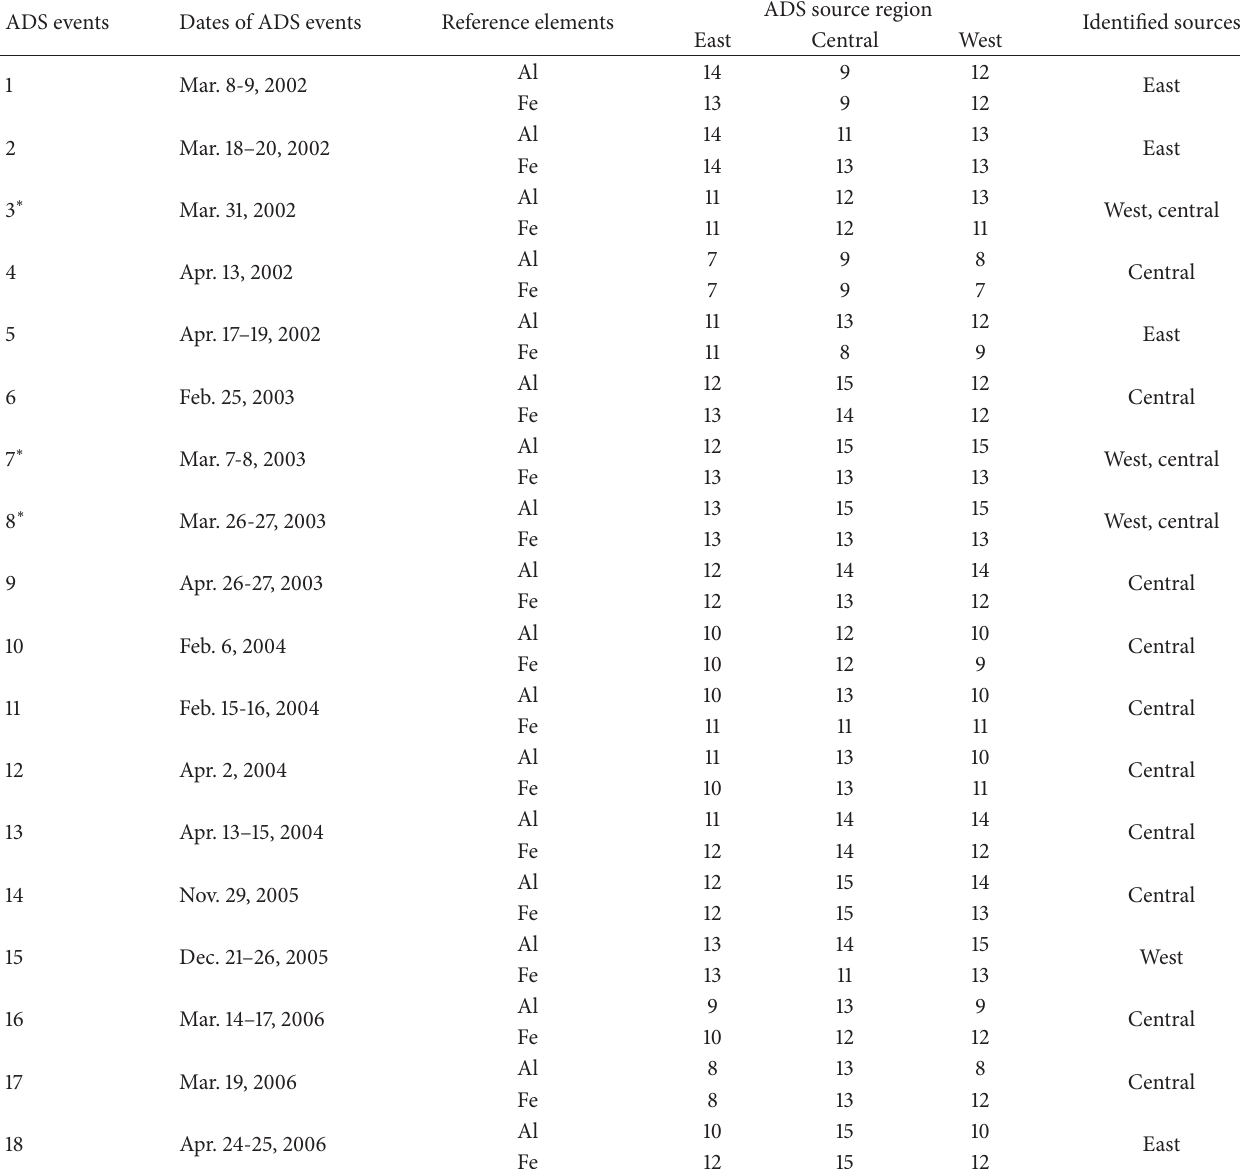
Table 2: Source allocation of 18 ADS events in the Inner Mongolia by enrichment factor analysis. ADS